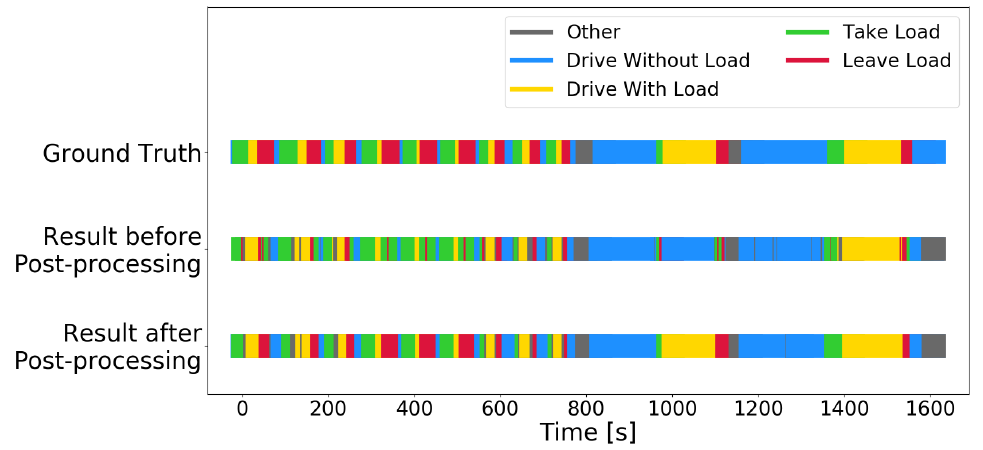
Figure 9. Ground truth and predictions (before and after post-processing) on each second in the 27-min hold-out test set.